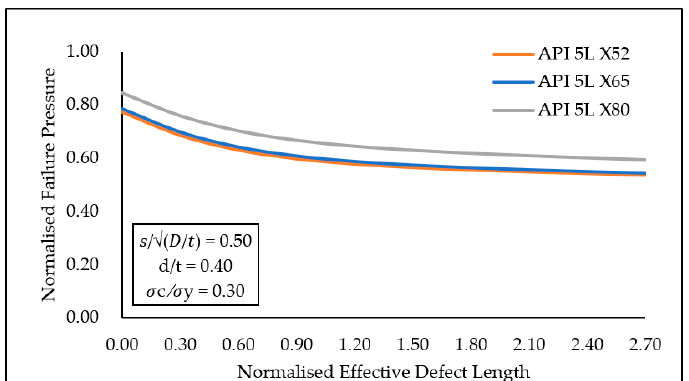
Figure 8. Failure pressure predictions for API 5L X52, X65, and X80 pipe for multiple normalised effective defect lengths.